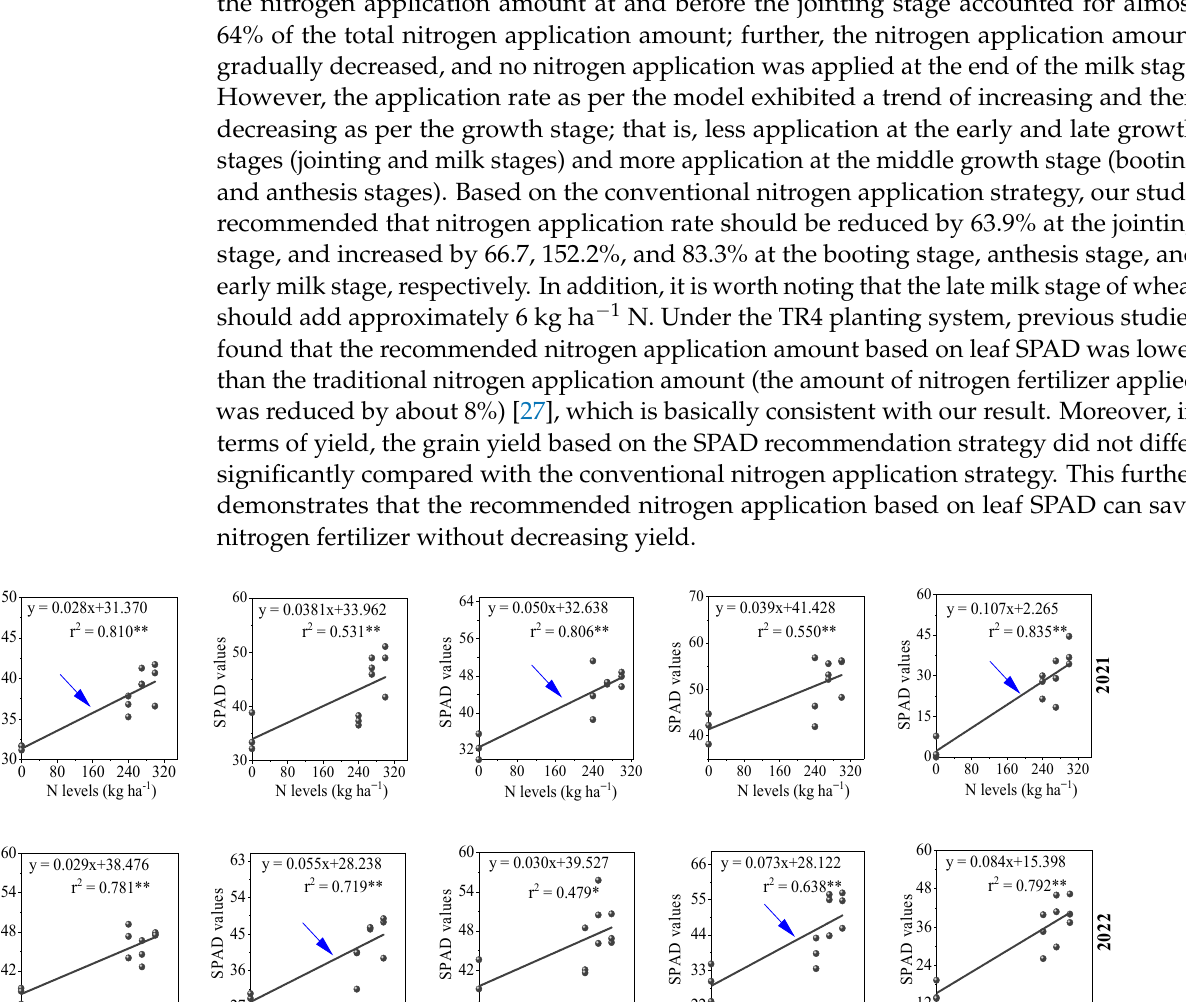
Figure 6. The relationship between nitrogen application levels and grain yield. Red numbers repre- sent the theoretical maximum grain yield in 2021 and 2022, which were 8083 and 8309 kg ha − 1 , re- spectively. ** indicates significant difference at the 0.01 level. Black numbers represent the nitrogen application level corresponding to the theoretical maximum grain yield in 2021 and 2022, which